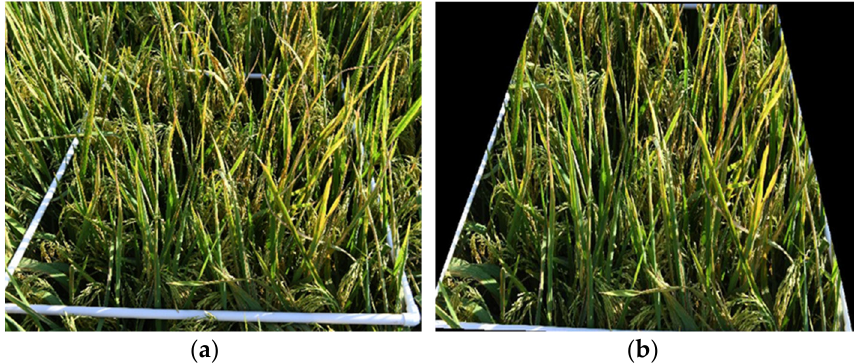
Figure 1. Images showing ( a ) initial sample data and ( b ) cropped sample data determined by the 1 × 1 m white box.